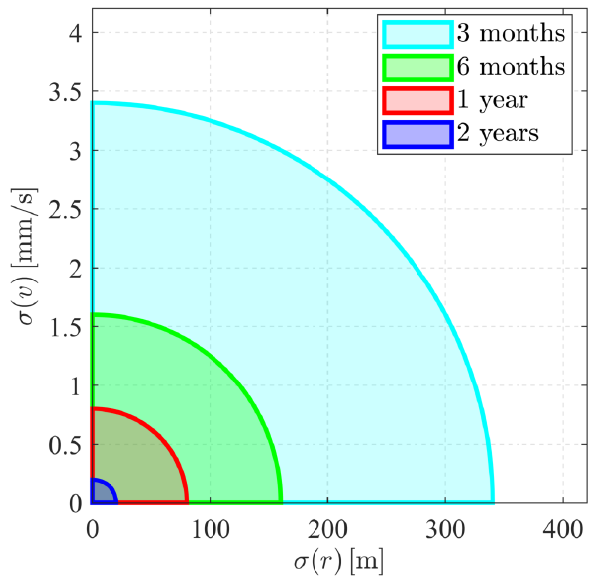
Figure 15. Stability domain of different mission life